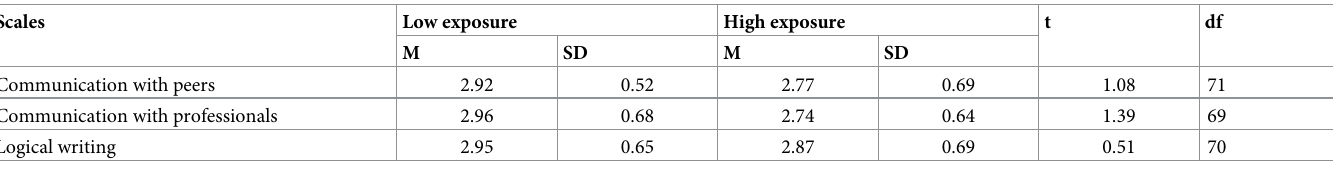
Table 4. Descriptive statistics and t -test results for language challenges (low exposure vs. high exposure).